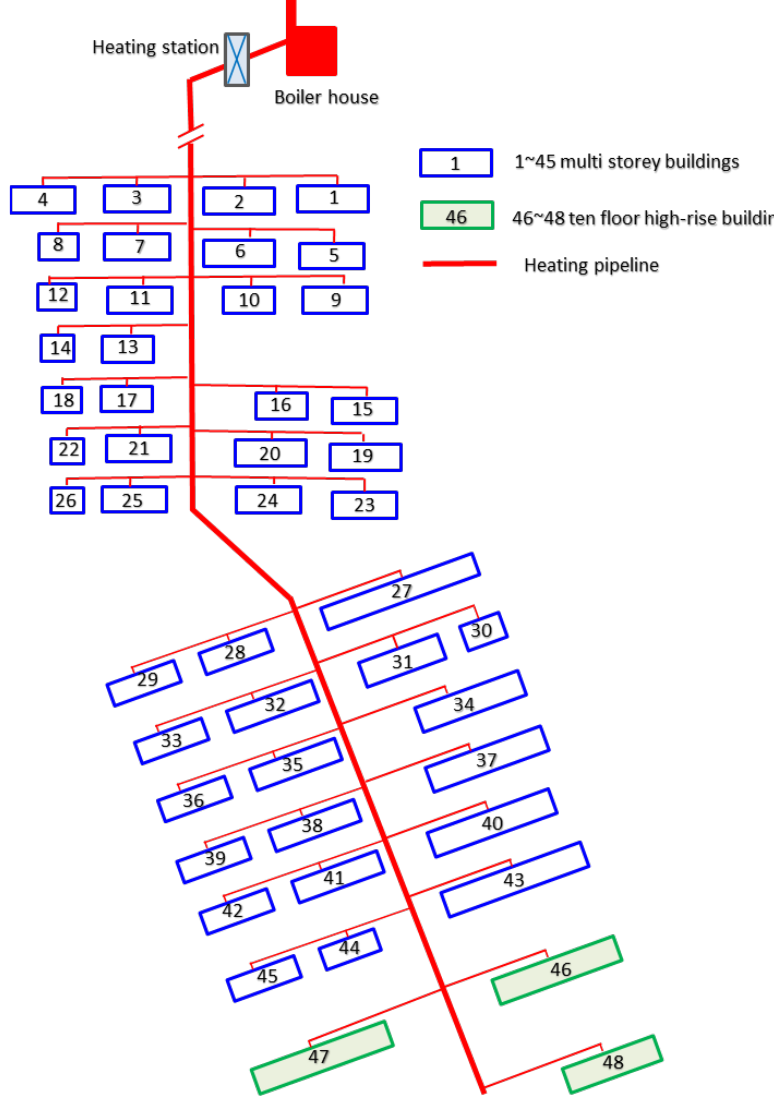
Figure 7. Layout of the studied heating system.